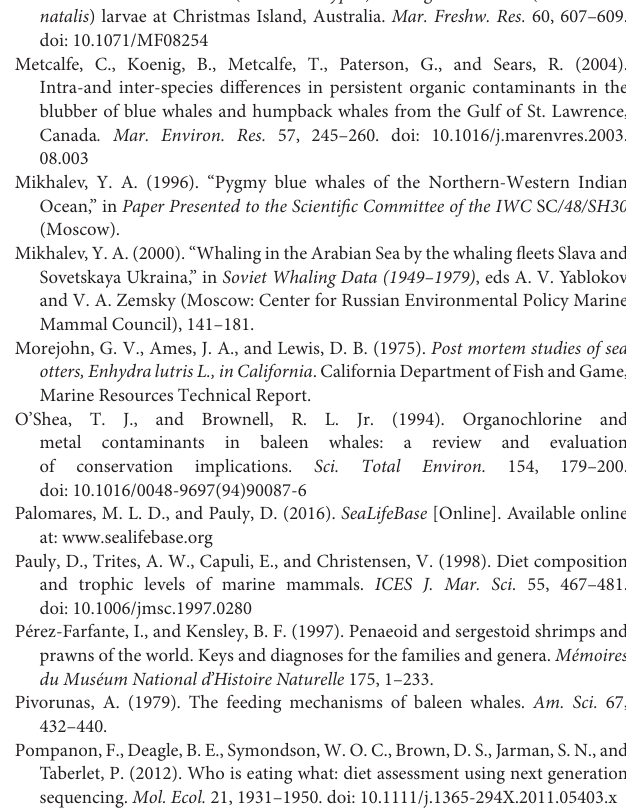
Taberlet, P. (2012). Who is eating what: diet assessment using next generation sequencing. Mol. Ecol. 21, 1931–1950. doi: